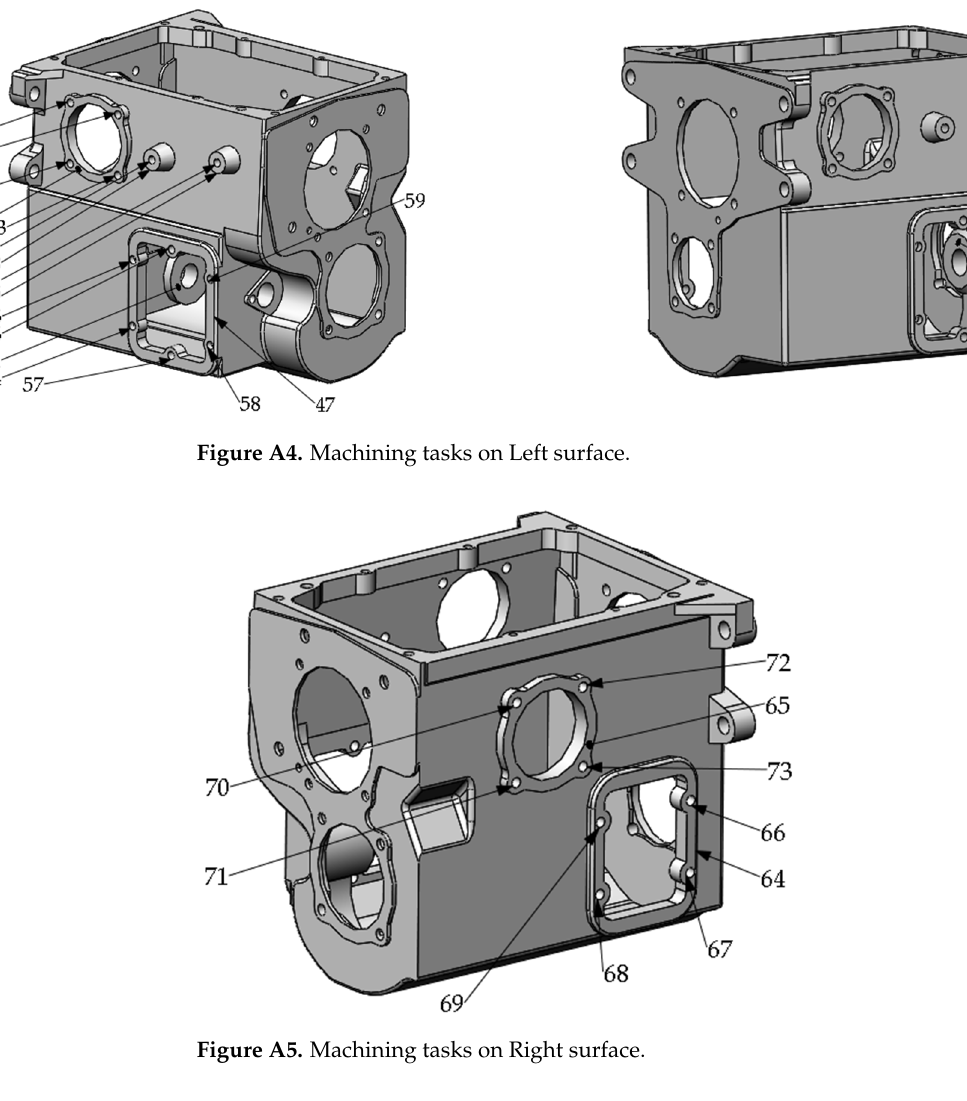
Table A1. Task operation procedure and time.